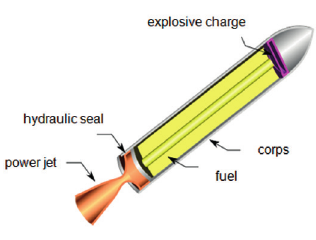
Fig. 6. Rocket engine using solid fuel